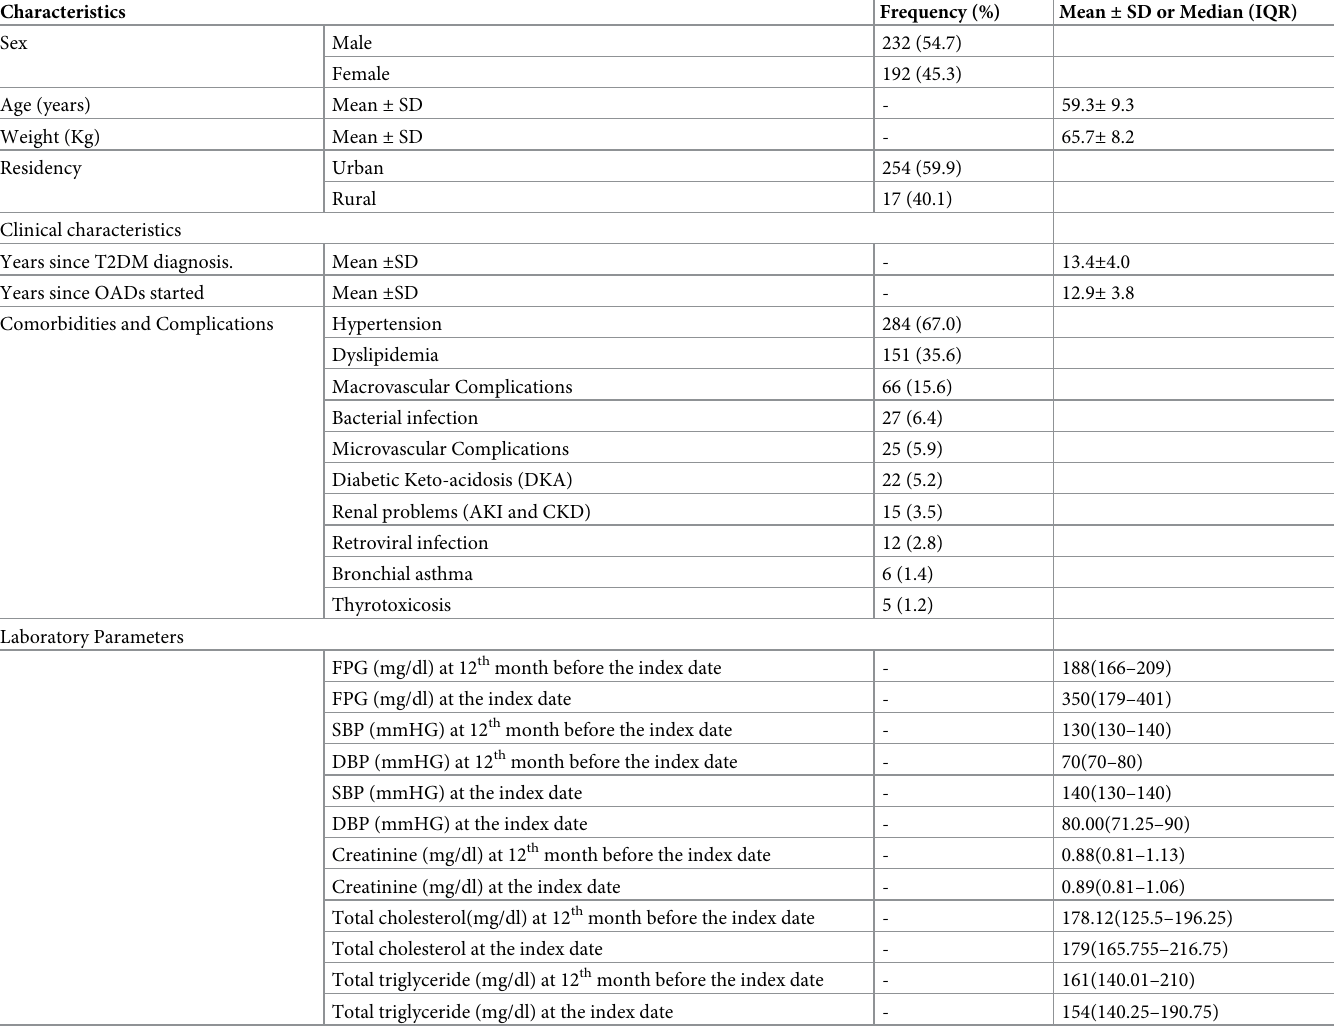
Table 1. Socio-demographic and baseline clinical characteristics of newly insulin-initiated patients with T2DM having follow-up at UoGCSH from 2015–2020 (N = 424).